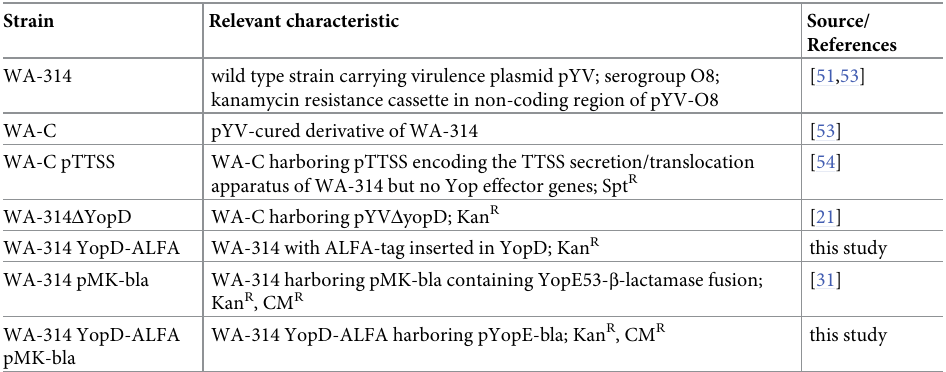
Table 1. Yersinia enterocolitica